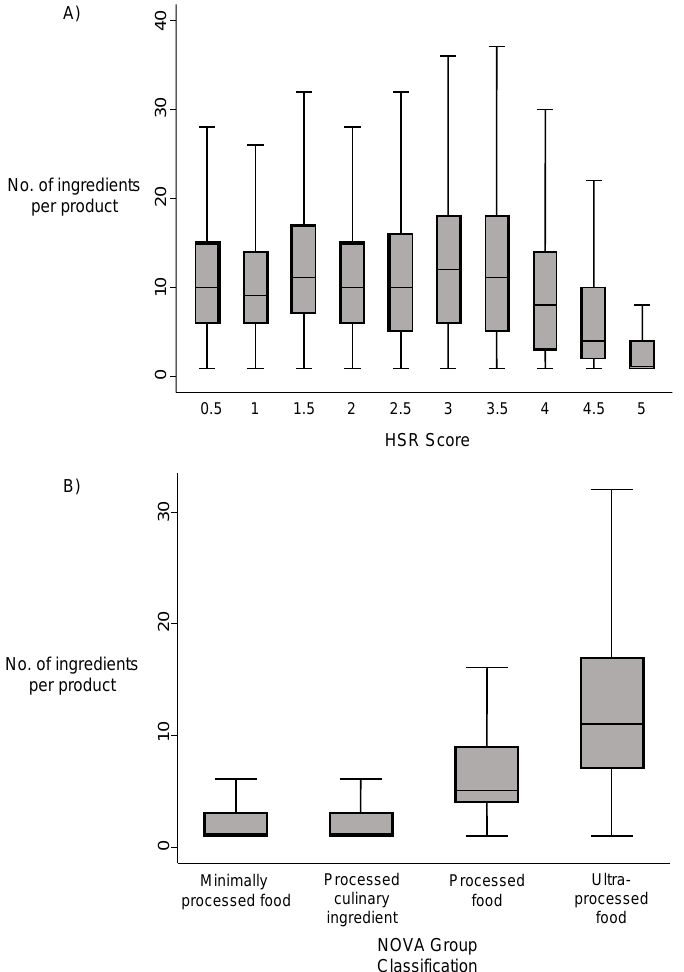
Figure 2. The association of the number of ingredients with ( A ) Health Star Rating and ( B ) NOVA classification. Box plot ( A ) shows the median and interquartile range (IQR) number of ingredients in products assigned different Health Star Rating (HSR) scores. The whiskers are defined as the lower quartile − 1.5 * IQR and the upper quartile + 1.5 * IQR. Outliers are excluded from the graph. Box plot ( B ) shows the median and interquartile range (IQR) number of ingredients in products assigned different NOVA classification groups. The whiskers are defined as the lower quartile − 1.5 * IQR and the upper quartile + 1.5 * IQR. Outliers are excluded from the graph.